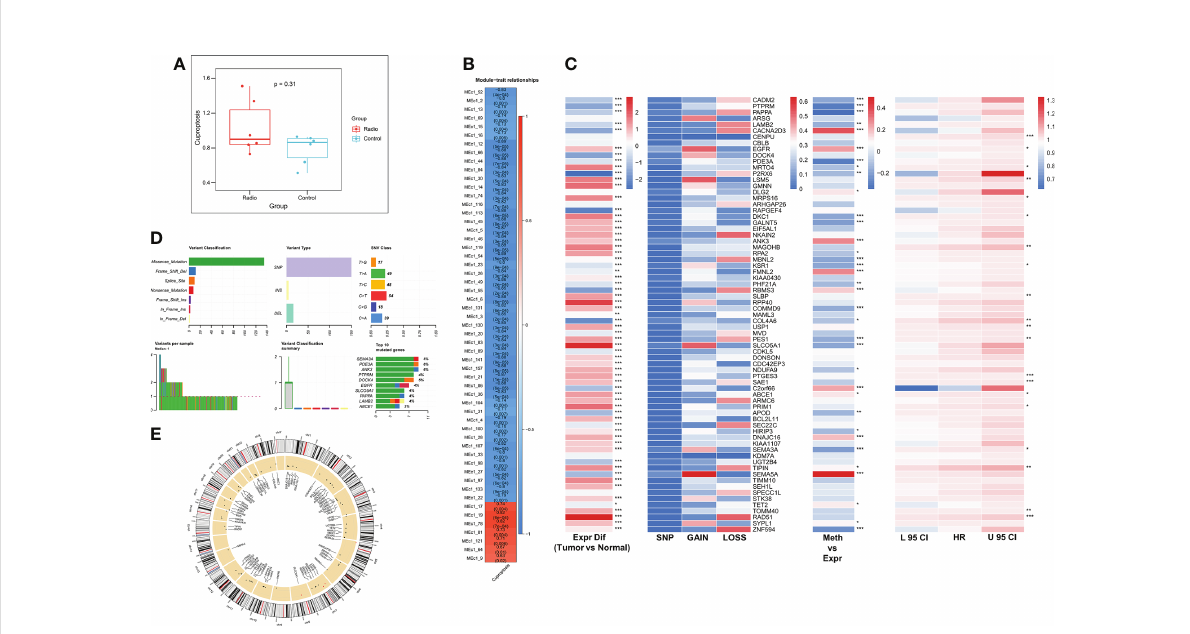
FIGURE 1 Identi fi cation of radiotherapy-associated CRGs. (A) Box plot showing Cuproptosis pathway activity before and after radiotherapy. (B) Identi fi cation of the most relevant gene modules for Cuproptosis. (C) Heat map showing genomic changes and hazard ratios of CRGs in TCGA-LUAD. From left to right were respectively: expression differences of CRGs in tumor and normal samples, frequency of mutations and copy number variants of CRGs, correlation of DNA methylation modi fi cations and expression of CRGs, and univariate Cox regression analysis showing risk ratios of CRGs. *p < 0.05, **p < 0.01, ***p < 0.001. (D) Summary of mutational events in CRGs in TCGA-LUAD. (E) Circle diagram demonstrating the CNV events of CRGs on